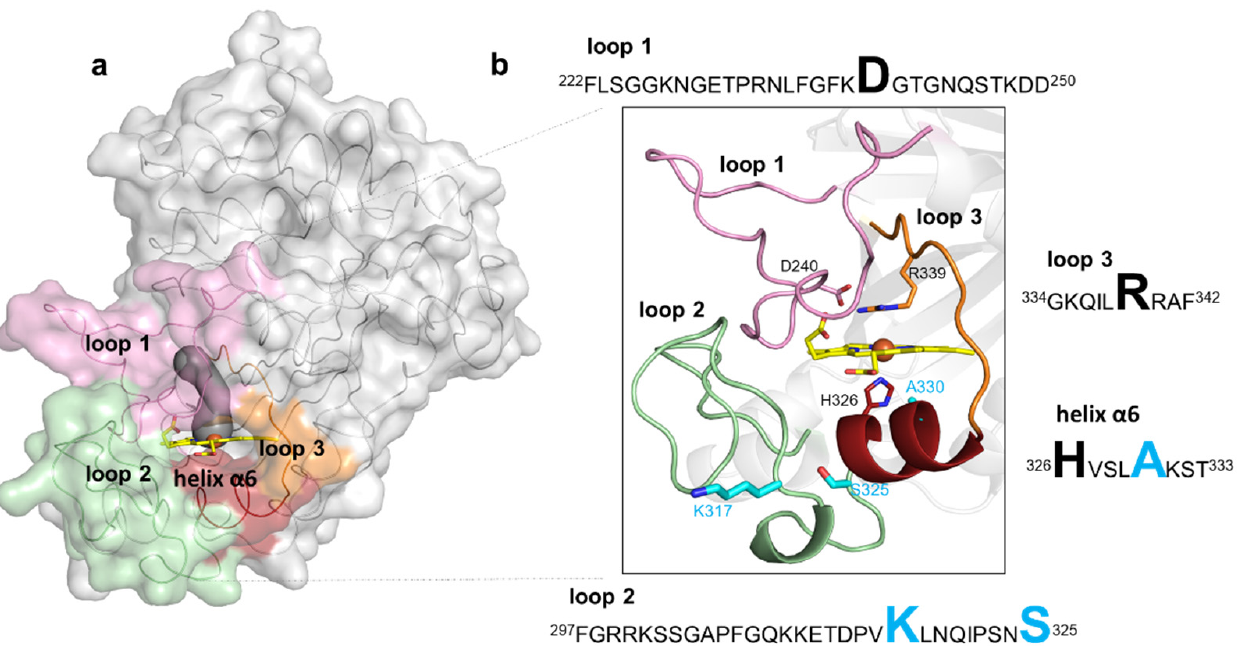
Figure 3. Representation of loops and the small helix delimiting the heme pocket in Bs DyP. ( a ) The Bs DyP monomeric form is shown as solvent-accessible surface colored in gray. The loops that surround the heme pocket are shown in pink (loop 1), green (loop 2) and orange (loop 3) and a small helix α 6 is represented in dark red. The access to the heme, as defined using a 1.4-Årolling probe, is made through a distal tunnel (in dark gray) and one cavity; ( b ) Zoomed view of the cartoon representation as shown in ( a ). The catalytic residues, D240 and R339, are shown as sticks with carbon atoms colored in pink and orange, respectively. The heme proximal ligand H326 is shown as sticks with carbon atoms colored in red. The residues K317, S325 and A330 that were replaced in the evolved variant 5G5 are shown as sticks with carbon atoms colored in cyan. The nitrogen and oxygen atoms are shown as sticks colored in blue and red, respectively. Highlighted in the text boxes are the catalytic residues (D240 and R339) and the heme proximal ligand (H326) in black, and the residues (K317, S325 and A330) that were replaced during the course of evolution in light blue. K317 (and D314 from loop 2) establishes salt bridges with D250 (and K248) from